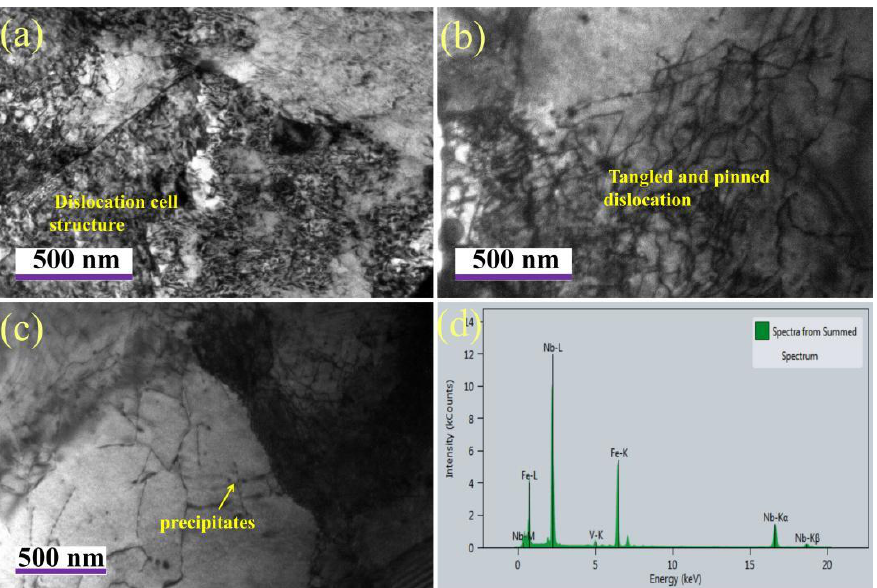
Figure 8. Dislocation morphology ( a , b ) and precipitation behavior ( c , d ) by TEM after tempering at 650 °C.